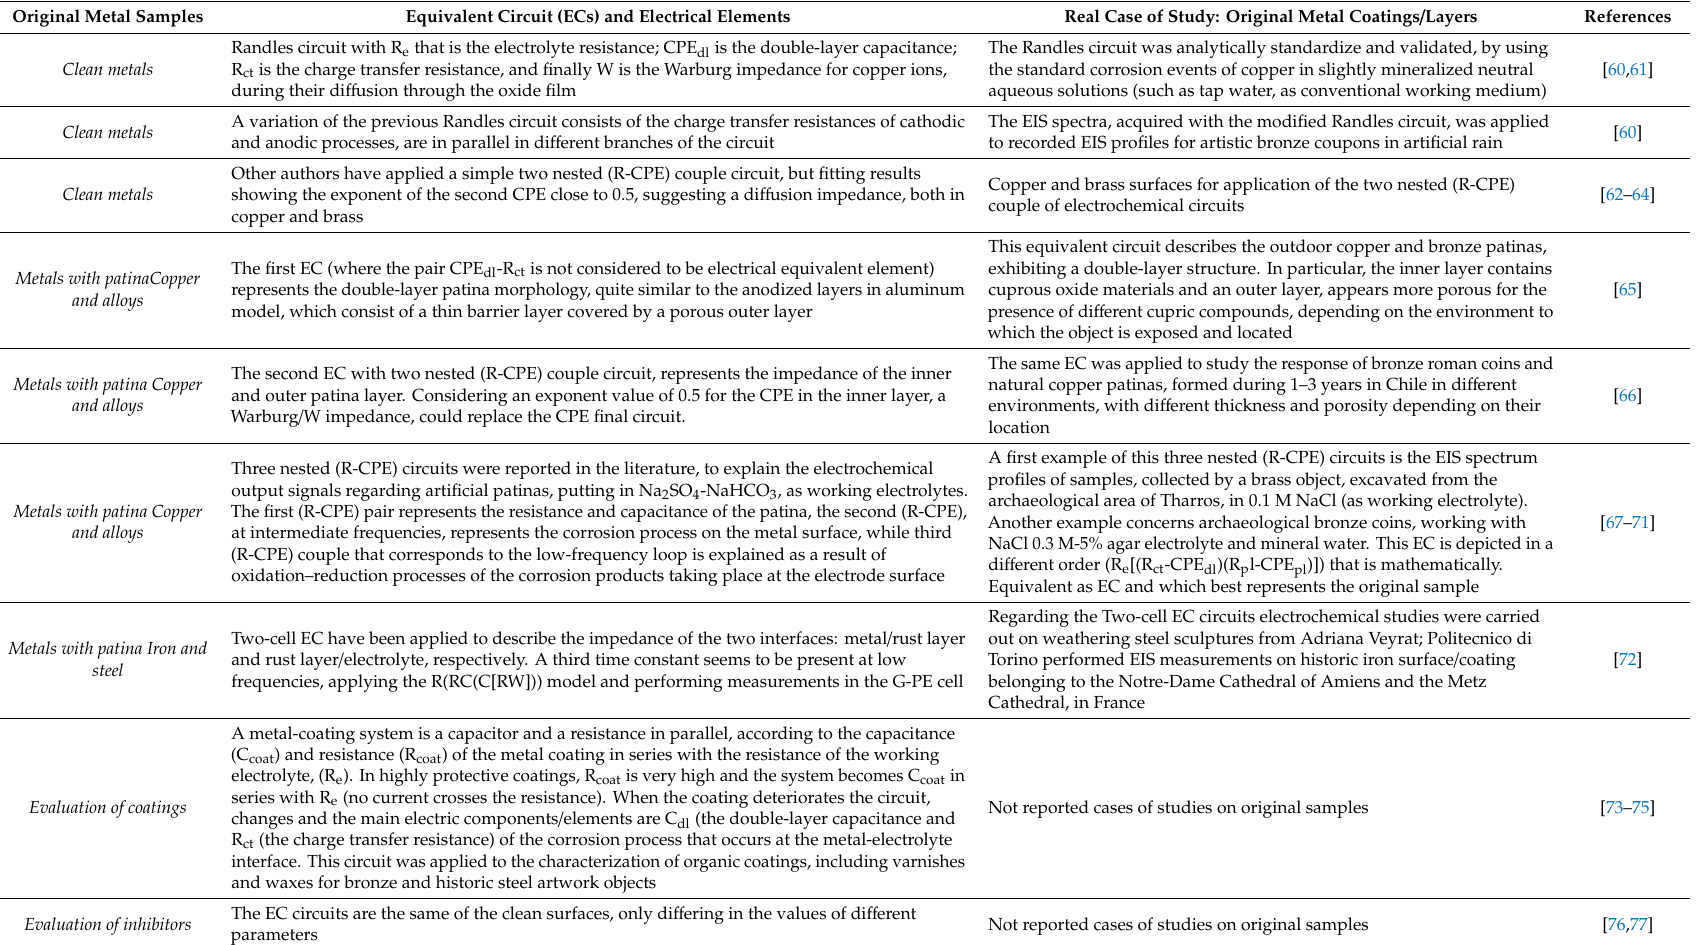
Table 1. The most representative cases of studies investigated by ECs for a correct EIS profiles / data